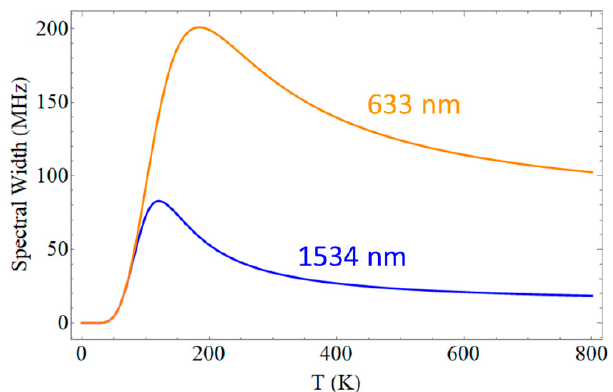
Figure 6. Brillouin spectral width simulation for pure silica at wavelengths of 633 nm and 1534 nm. Far from the peak, the spectral width is proportional to ν B 2 . The spectral width is proportional to the acoustic attenuation coefficient.